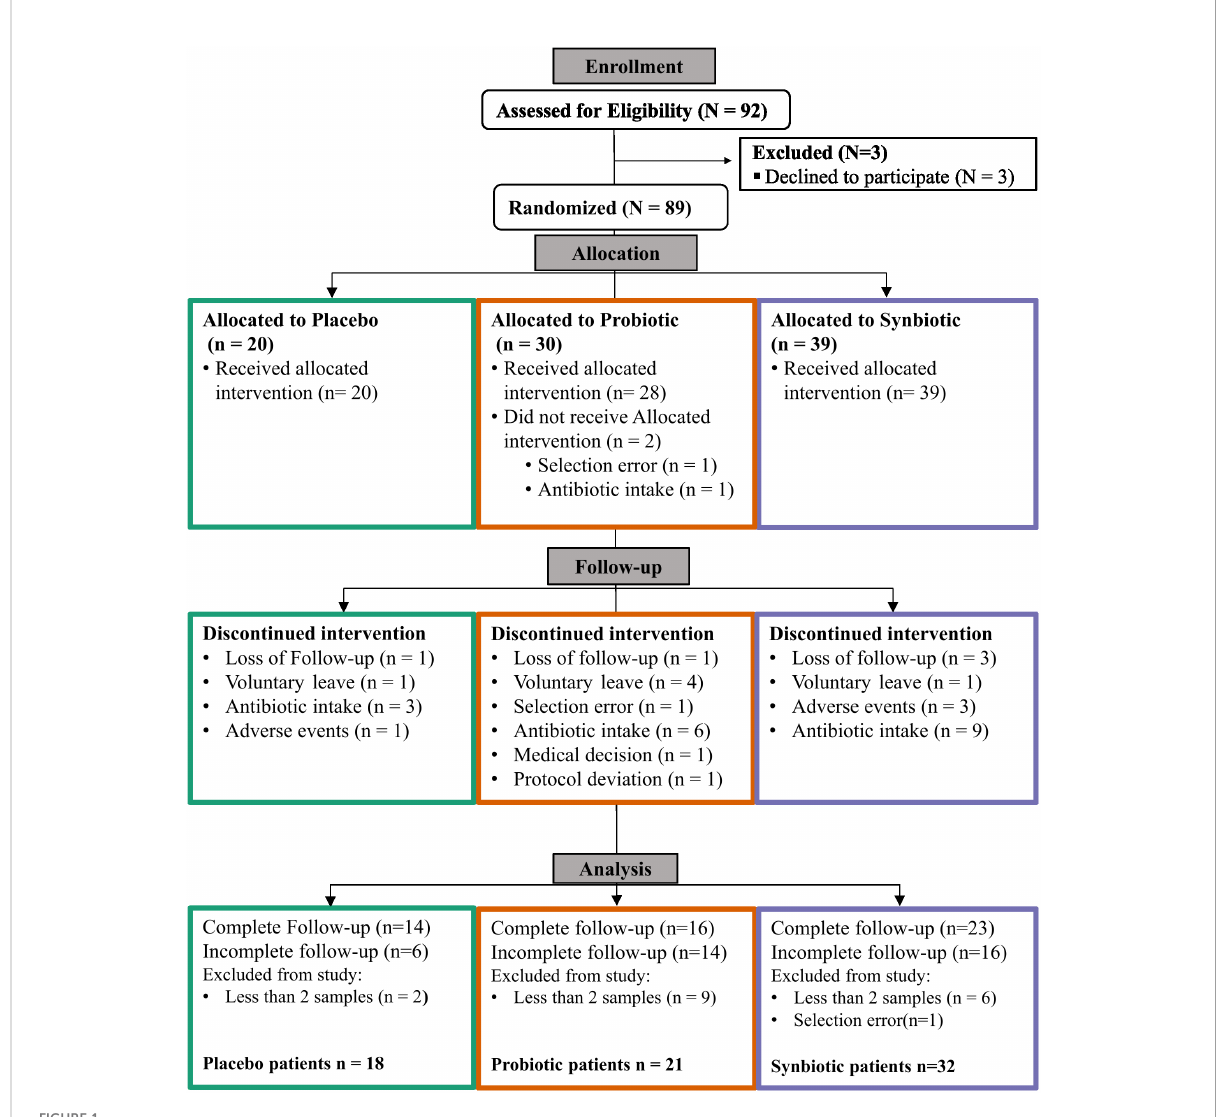
FIGURE 1 CONSORT (Consolidated Standards of Reporting Trials) Flow